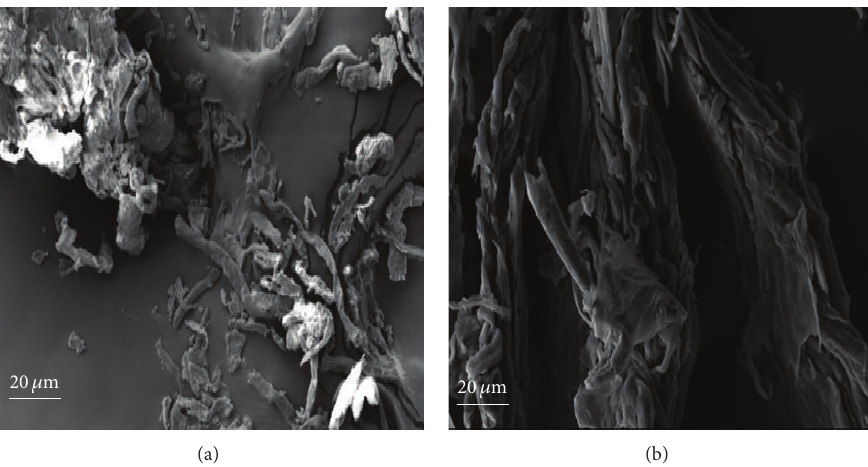
Figure 6: SEM images of sulfuric acid extracted cellulose from wheat straw (a) and Albright-Goldman oxidized cellulose (b).